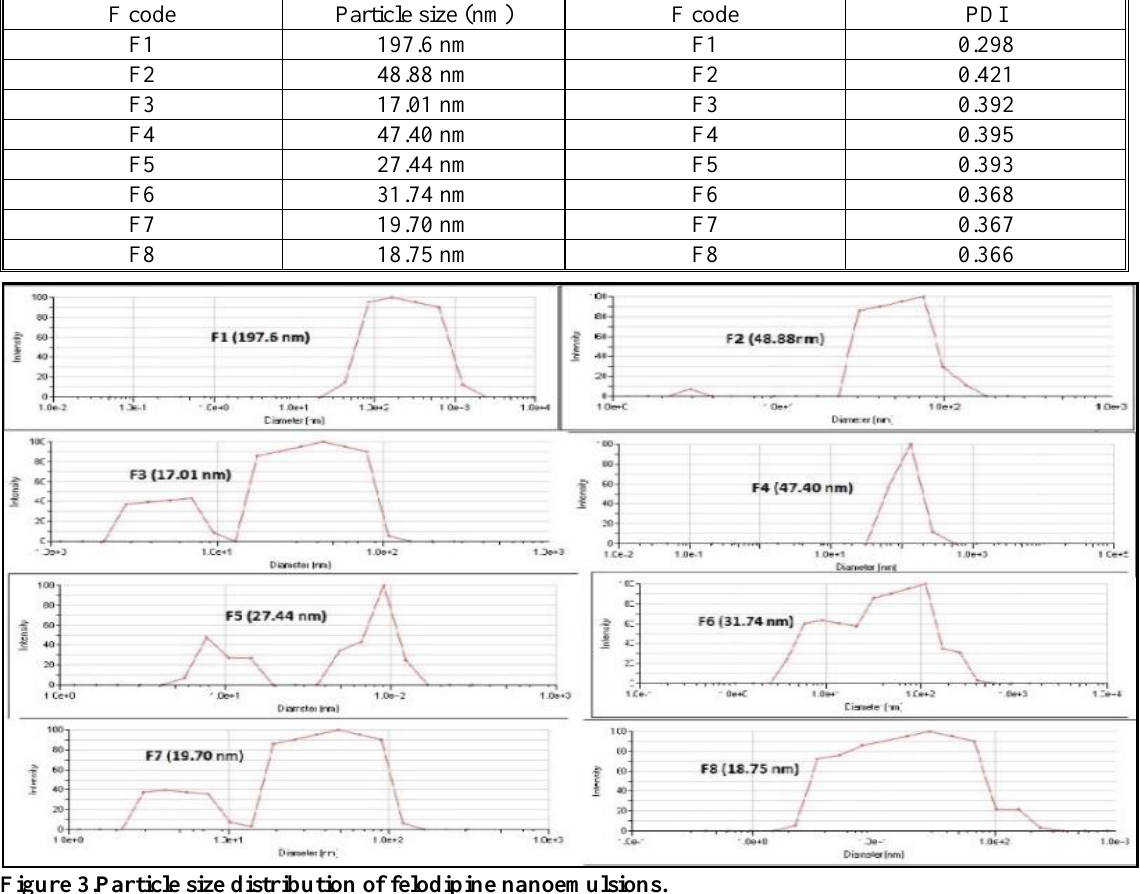
Table 4. Particle size and poly pisprersity index of the NE formulas.